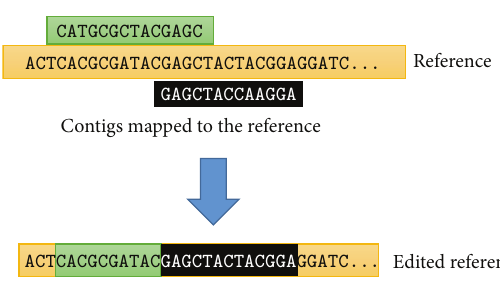
Figure 3: Resolution of ambiguity. First, for each contig, its best mapping is determined, and then the remaining ambiguity is resolved in greedy fashion by giving priority to the beginning of the contigs as shown in the